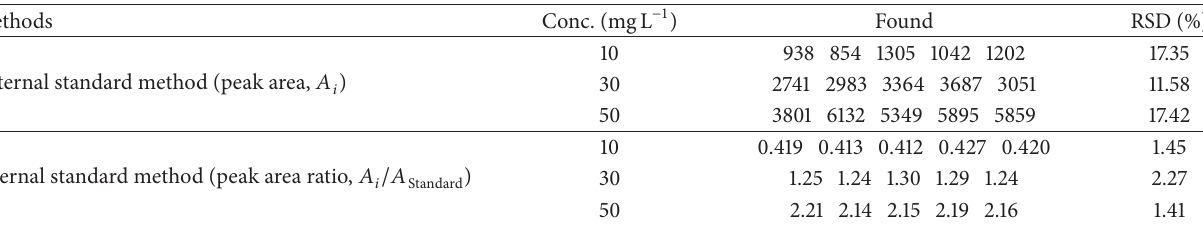
Internal standard method (peak area ratio, 𝐴 𝑖 /𝐴 Standard